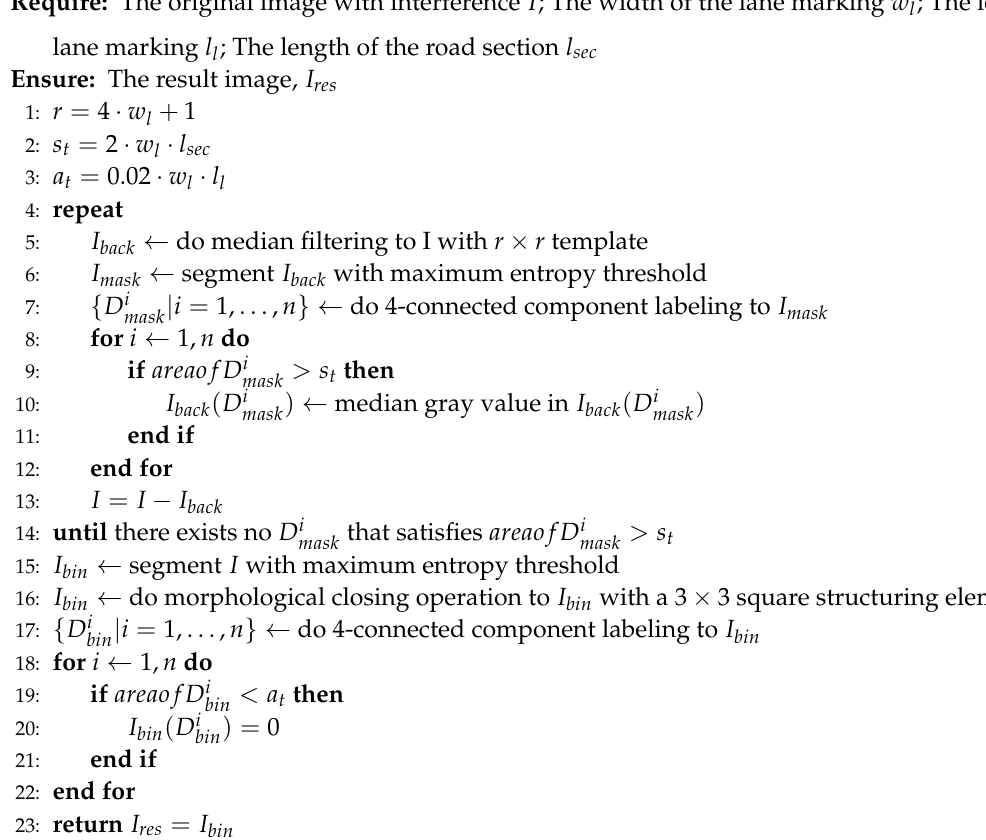
Algorithm 1 Self-adaptive